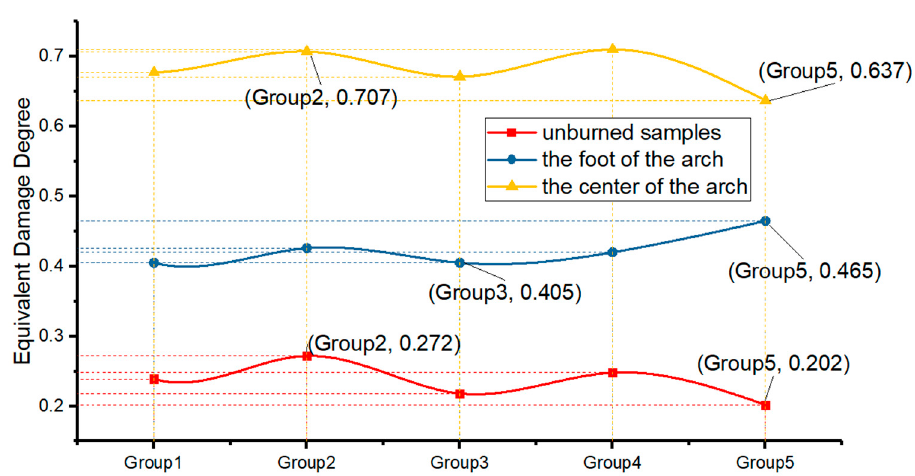
Figure 21. The 30 KG impact test for different parts of concrete lining structure.